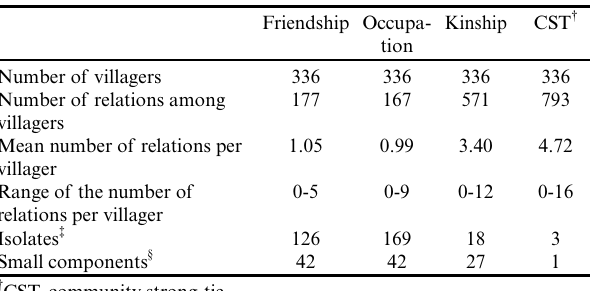
Table 2 . Main characteristics of the strong-tie networks.